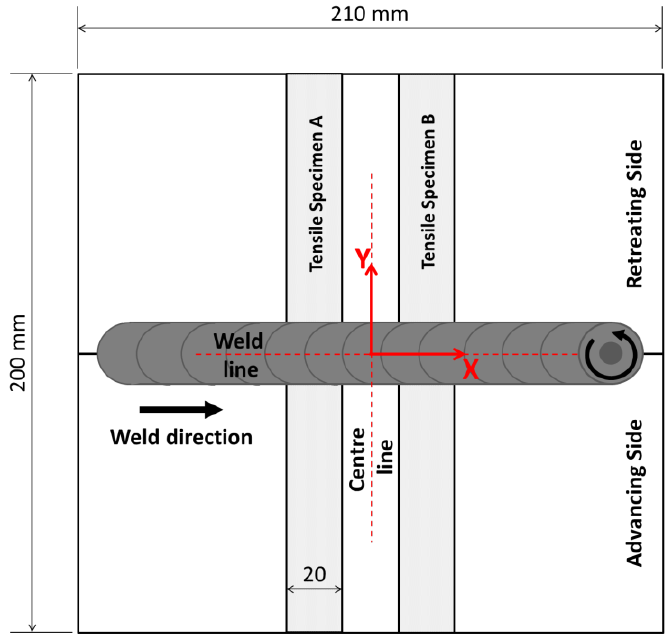
Figure 4. Schematic view of the weld: the tool transverse and rotation directions, the coordinate system and the measure lines are